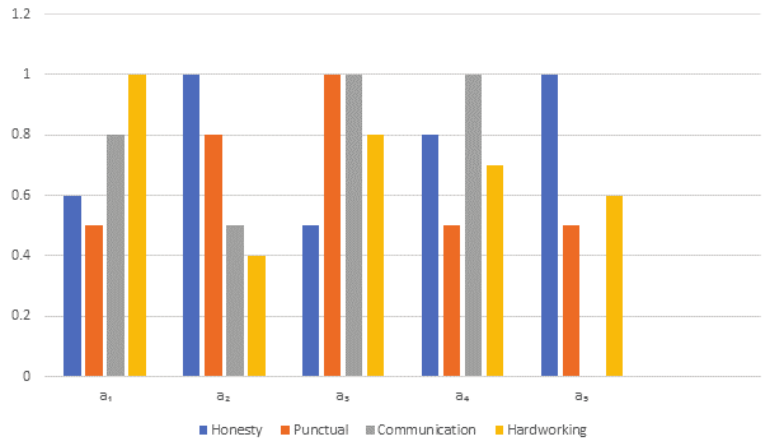
Figure 1. Graphical representation of 4-polar fuzzy subset. Here, 1 represents good remarks, 0.5 represents average and 0 represents bad